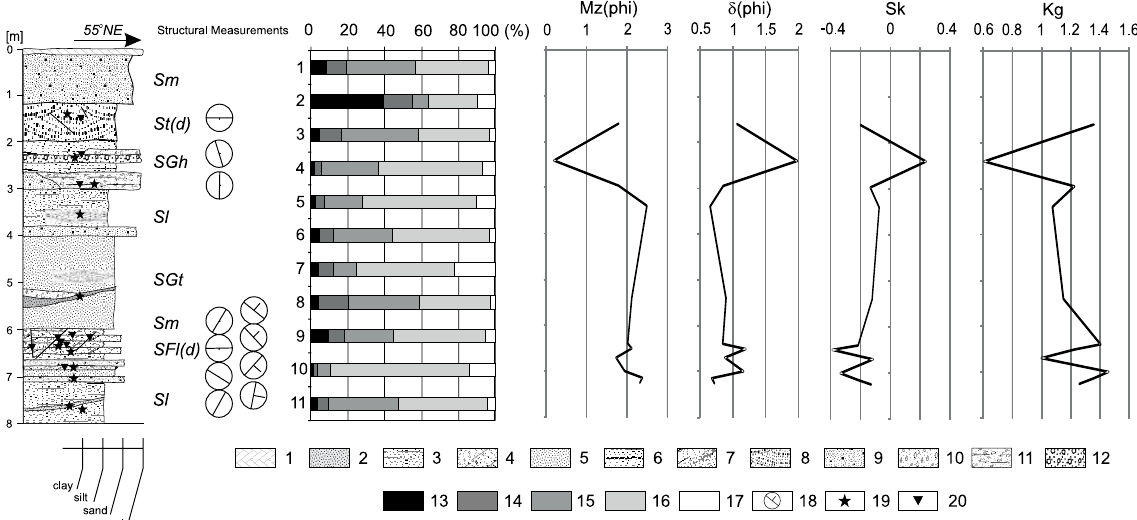
Fig. 4. the lithofacies structure of the Piaski Pomorskie site. the percentage content of primary fractions, the value of granulation